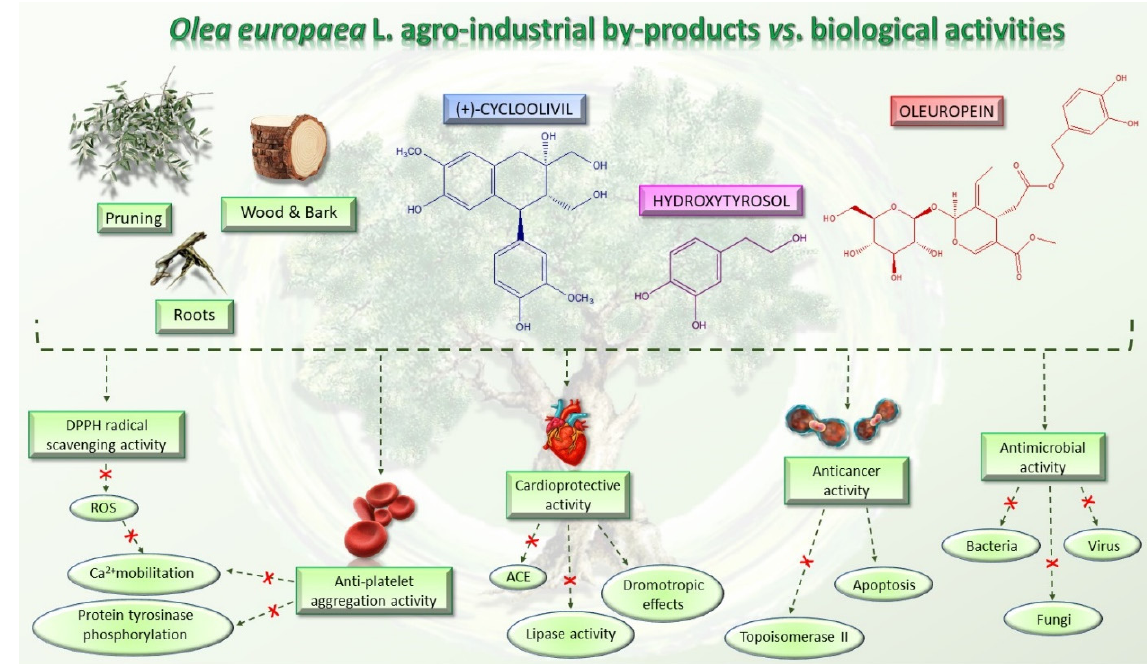
Figure 5. Graphical representation of O. europaea agro-industrial by-product biological activity. Extracts from olive roots, pruning, wood, and bark, showed antioxidant, antimicrobial, anti-platelet aggregation, and anticancer activities. These activities are related to the high content in bioactive compounds like oleuropein, hydroxytyrosol, and (+)-cycloolivil.